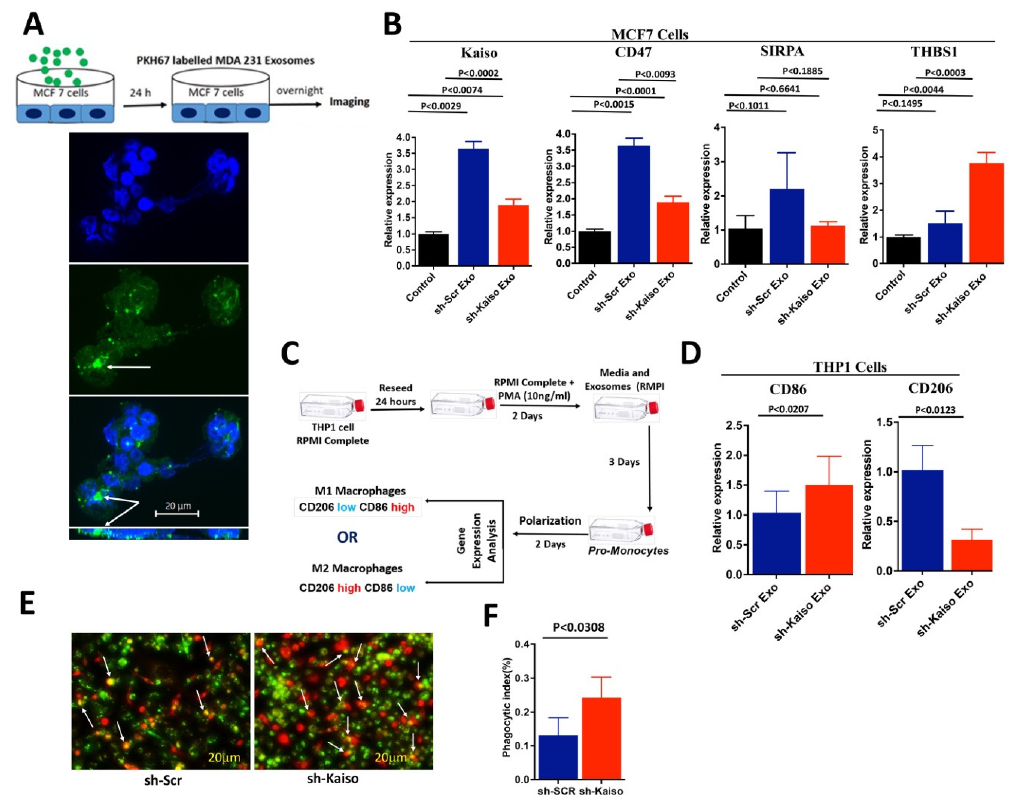
Figure 5. Exosomes act as cell-to-cell communication vehicles influencing MCF7 cells following treatment with exosomes. ( A ) Internalization of exosomes from MDA-MB-231 cells was con fi rmed by the uptake of exosomes in recipient MCF7 cells by using PKH67 polylinker dye (white arrows highlight exosome in Z-stack image). ( B ) MCF7 cells treated with Kaiso-depleted exosomes showed low expression of Kaiso, CD47, and SIRPA, but high expression of THBS1. The statistical method used was one-way ANOVA. ( C ) Polarization of THP1 cells using exosomes from Kaiso-depleted cells was assessed to demonstrate the in fl uence of exosomes as communication vehicles by observ- ing the expression of M1 and M2 macrophage markers. ( D ) Consistent with sh-Kaiso xenograft tis- sues (Figure 4F), THP1 cells treated with exosomes from sh-Kaiso cells showed a high expression of CD86 and a low expression of CD206, a marker for M1 macrophages; in contrast, THP1 cells treated with exosomes from sh-Scr cells showed a low expression of CD86 and a high expression of CD206, a marker for M2 macrophages. The statistical method used was the two-tailed paired t test. ( E , F ) BMDM treated with sh-SCR and sh-Kaiso cells showed higher phagocytosis (white arrow indicates phagocytosis) of sh-kaiso cells as compared to sh-SCR cells. The statistical method used was the two-tailed paired t test.